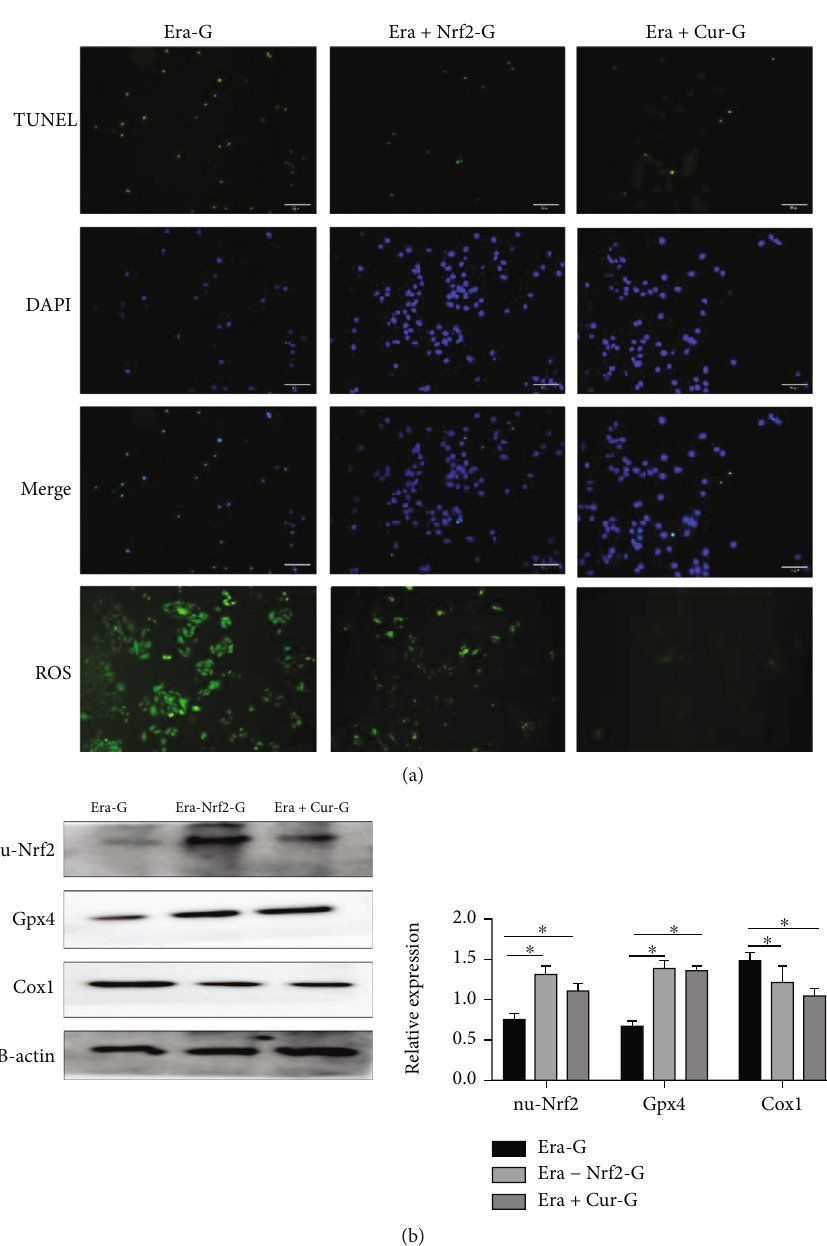
Figure 4: Curcumin prevents cardiac damage caused by erastin. Era-G: erastin-treated cardiomyocytes; Era+Nrf2-G: Nrf2 overexpressing +erastin-treated cardiomyocytes; Era+Cur-G: curcumin+erastin-treated cardiomyocytes. (a) Terminal deoxynucleotidyl transferase dUTP nick-end labelling (TUNEL) and reactive oxygen species (ROS) assays revealed that ferroptosis inducers caused massive myocardial cell death. The apoptosis rate and intracellular ROS were signi fi cantly reduced vs. the Era-G cells ( × 200). (b) Western blot detected the expression levels of nuclear Nrf2 and ferroptosis-related factors ( ∗ P < 0 : 05